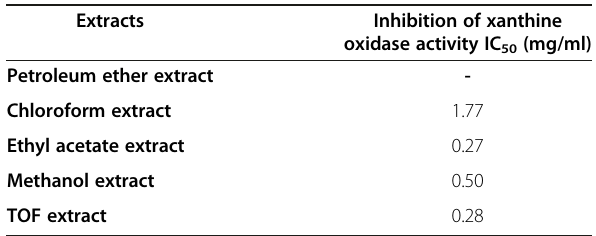
Table 4 D. gnidium leaf extracts IC 50 for inhibition